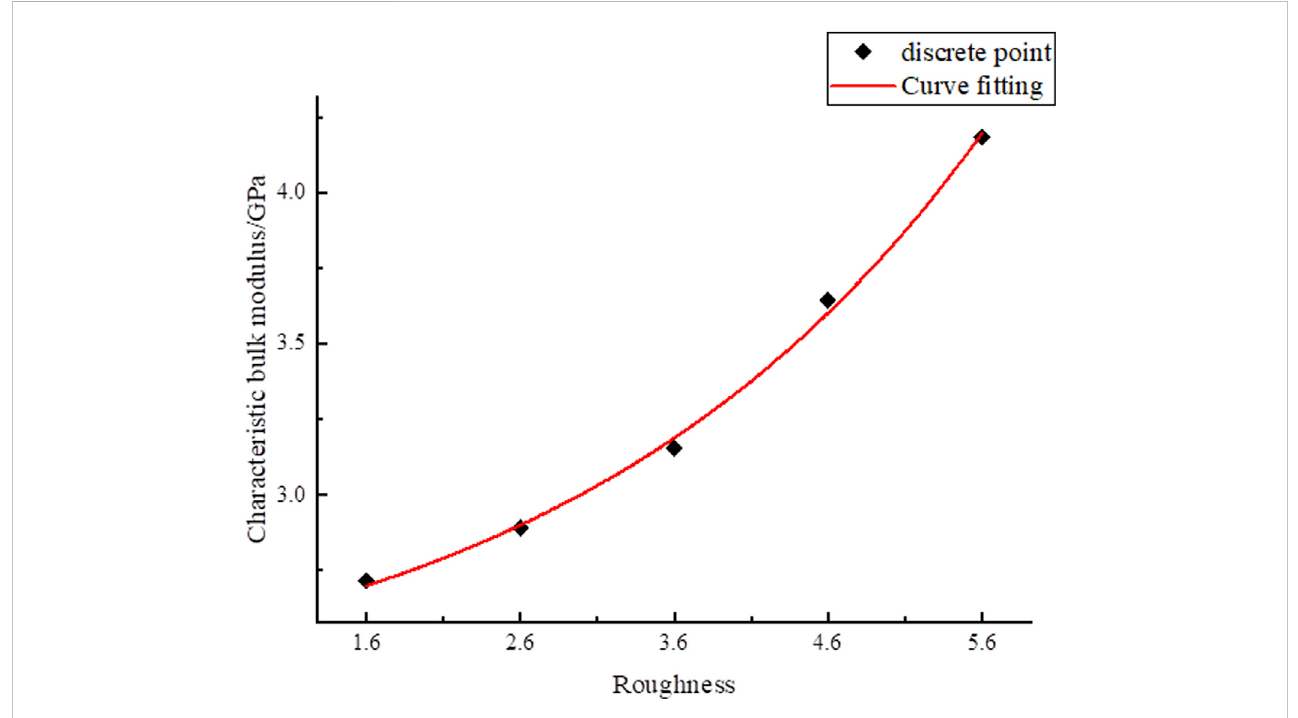
FIGURE 9 Fitting curve of CBM.